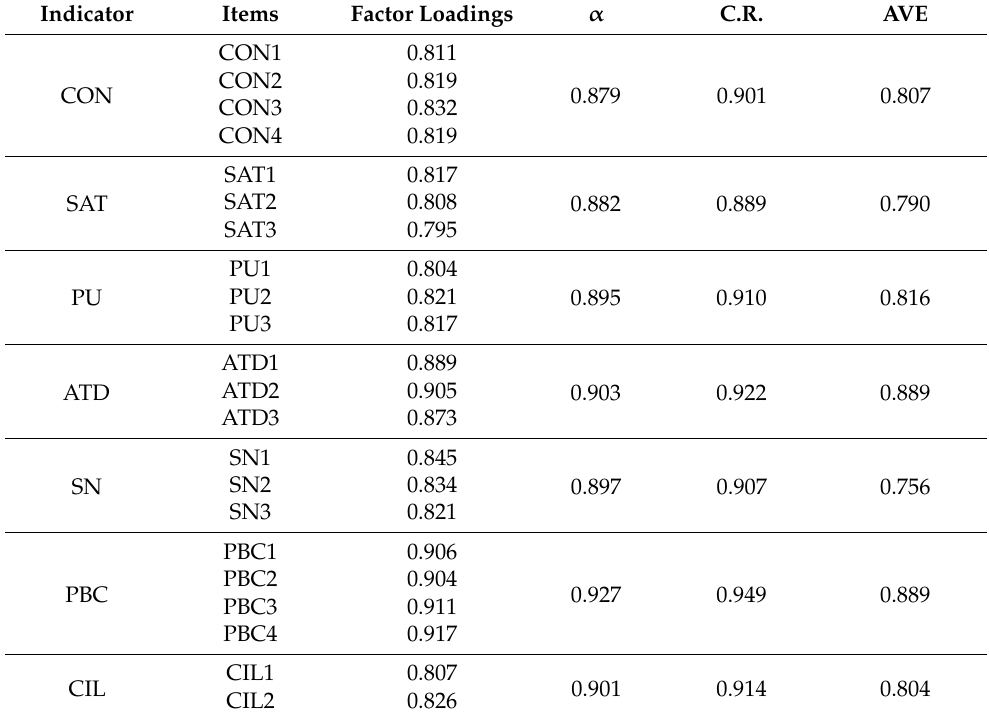
Table 3. Measurement model.